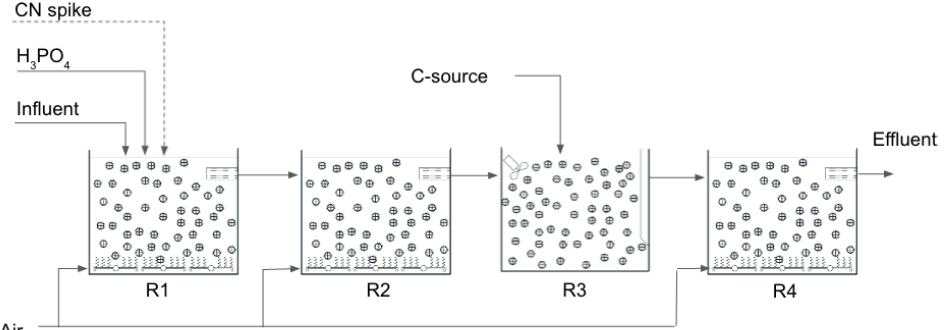
Figure 3. Pilot plant process schematic.